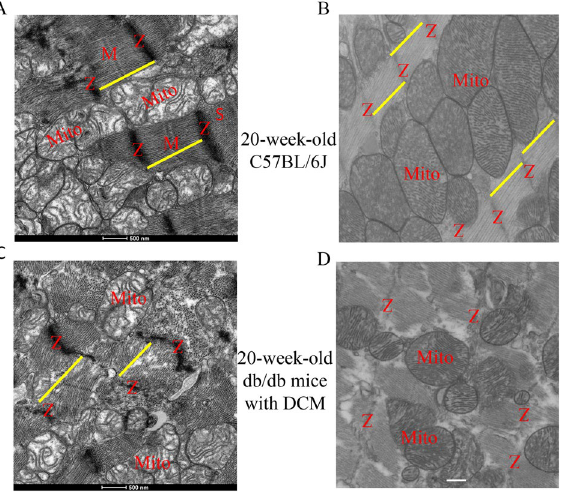
Figure 6. Transmission electron microscopy micrographs of myocardial myofilaments and mitochondria in db/db mice with diabetic cardiomyopathy and controls. (A) Non-diabetic control ventricle showed well- defined sarcomeres (yellow line) with distinguishable Z-lines (Z) and M-lines (M) throughout the tissue; (B) non-diabetic control ventricle showed well-organized sarcomeres and mitochondria (Mito); (C) the sarcomeric structure of db/db mice with DCM was less organized, with blurred Z-lines and absent M lines; (D) in db/ db mice with DCM, Z-lines were disarrayed, the sarcomeres were damaged, and mitochondrial volumes were decreased. Scar bar: 500 nm.